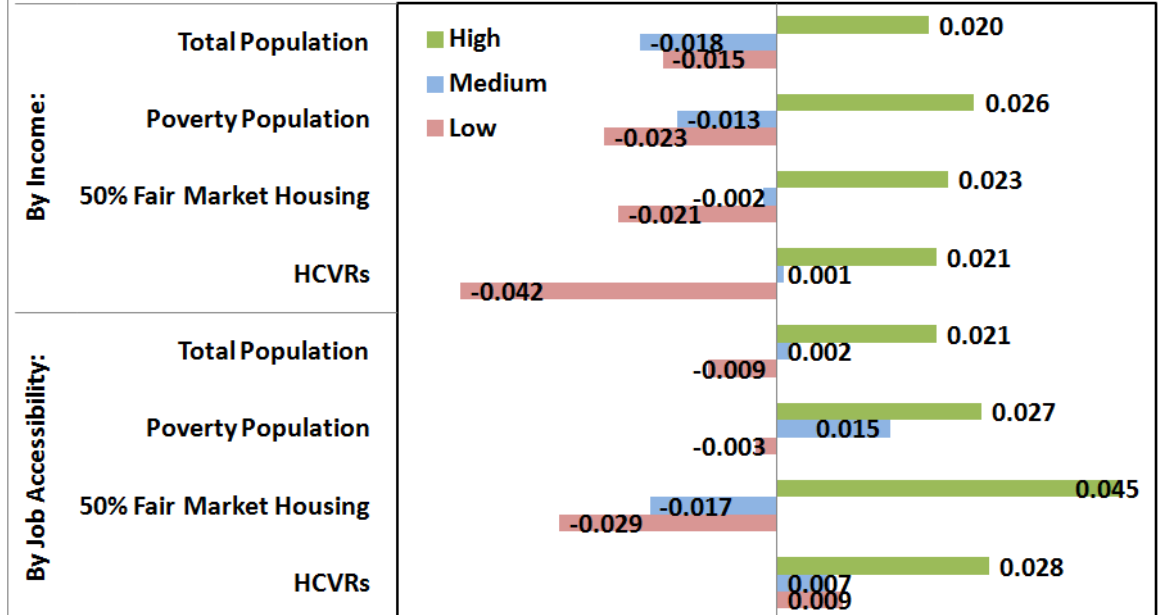
Figure 2. Change in distribution of population, poor, FMR Units and HCVRs by select suburban characteristics, Figure 3: Regional Differences in the Change of Key 2000–2008. Source: author’s analysis of HUD data, Census 2000 and ACS five-year estimates 2005−2009, an early version of the figure is presented in Covington, Freeman and Stoll (2011).